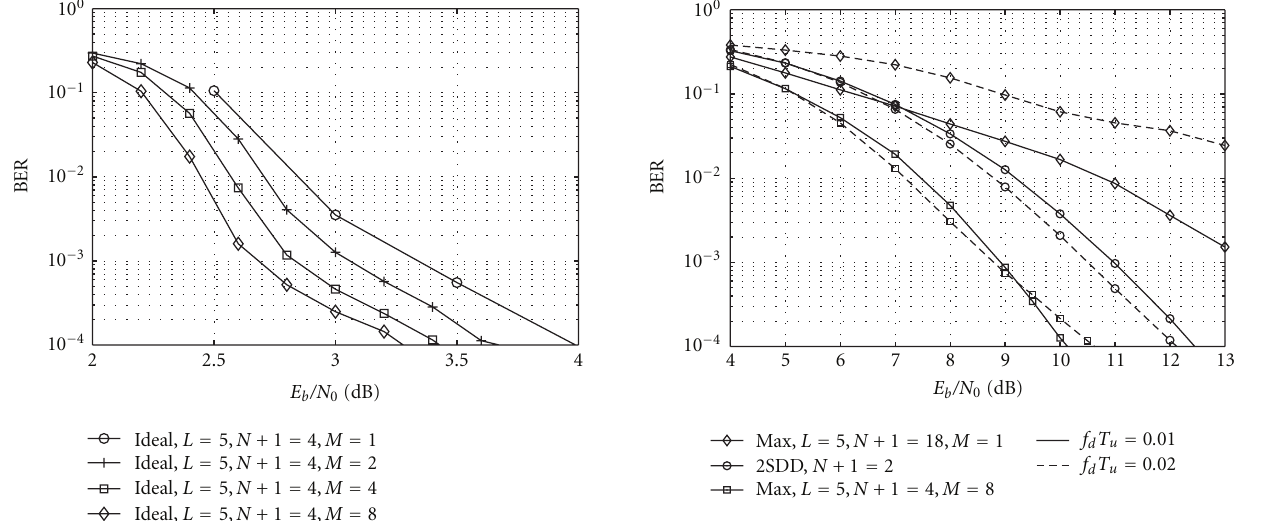
Figure 12: Bit-error performance for the multi-carrier case for di ff erent values M , where N + 1 = 4 and for L = 5 iterations.